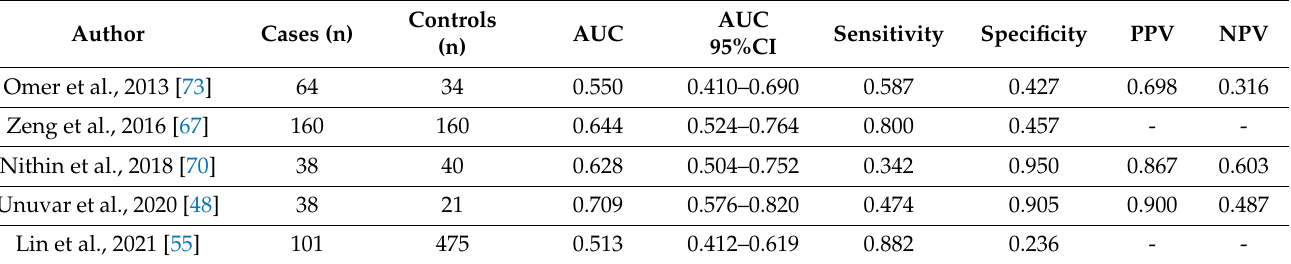
Table 9. Summary table of the performance of